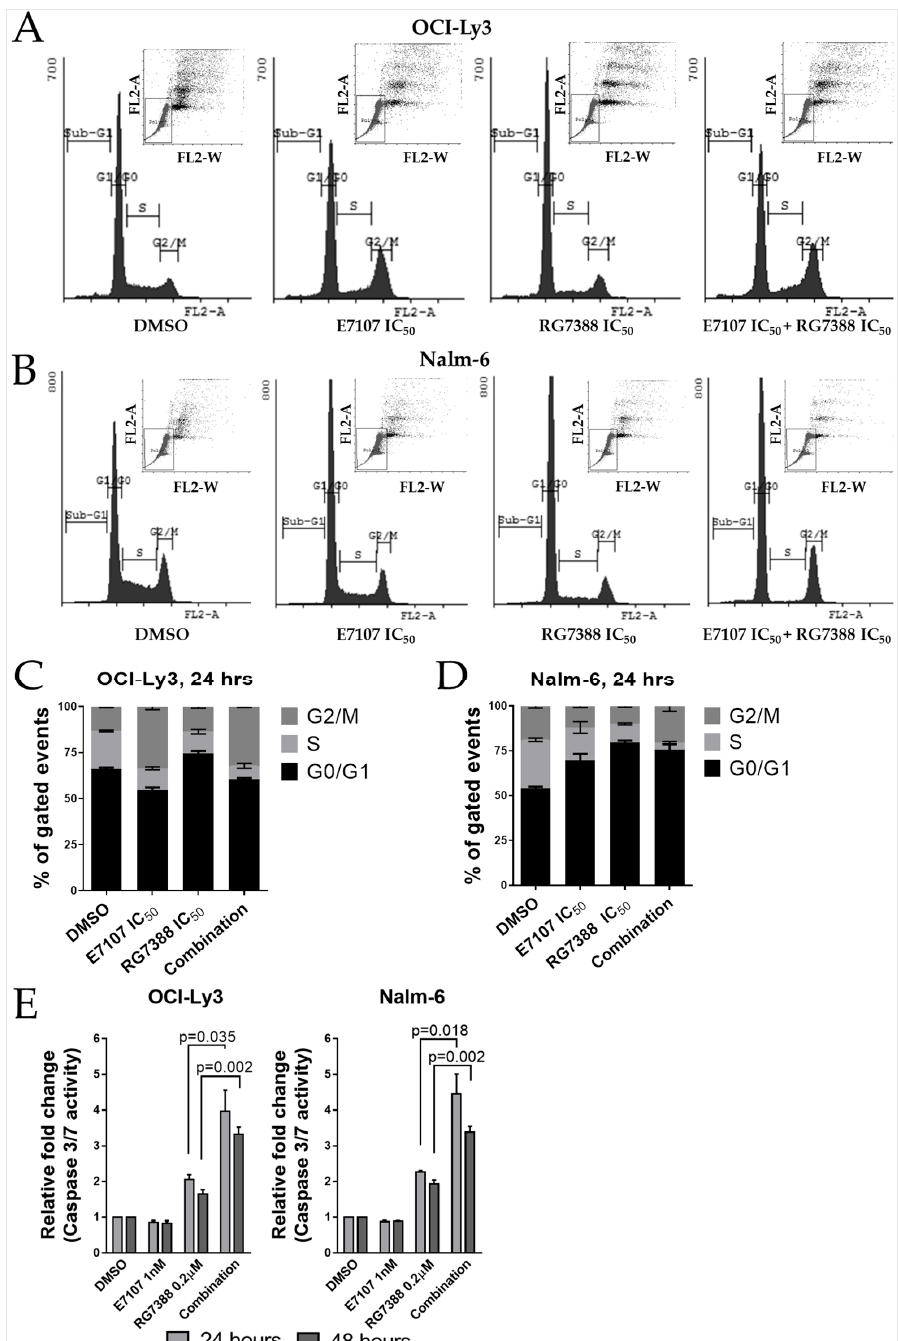
Figure 5. The effect of E7107 on the cell cycle distribution and apoptosis was indicated by caspase 3/7 activity when combined with RG7388. FACS DNA content histograms of TP53 WT B-cell lym- phoma cell line OCI-Ly3 ( A ) and B-cell precursor leukaemia cell line Nalm-6 ( B ) treated with RG7388 or E7107, and in combination at 1x of their respective IC 50 concentrations for 24 h. A minimum of 50,000 total cells were analysed per sample. FL2-A vs. FL2-W scatter plots were used to manually gate the single cells as shown in the upper right corner of each histogram. Cell cycle distribution changes by FACS analysis for OCI-Ly3 ( C ) and Nalm-6 ( D ). ( E ) Caspase 3/7 activity as a mechanistic indicator of apoptosis. Caspase 3/7 activity is represented as fold change relative to DMSO solvent control. Data are shown as the mean ± standard error of the mean (SEM) of at least four independent repeats.